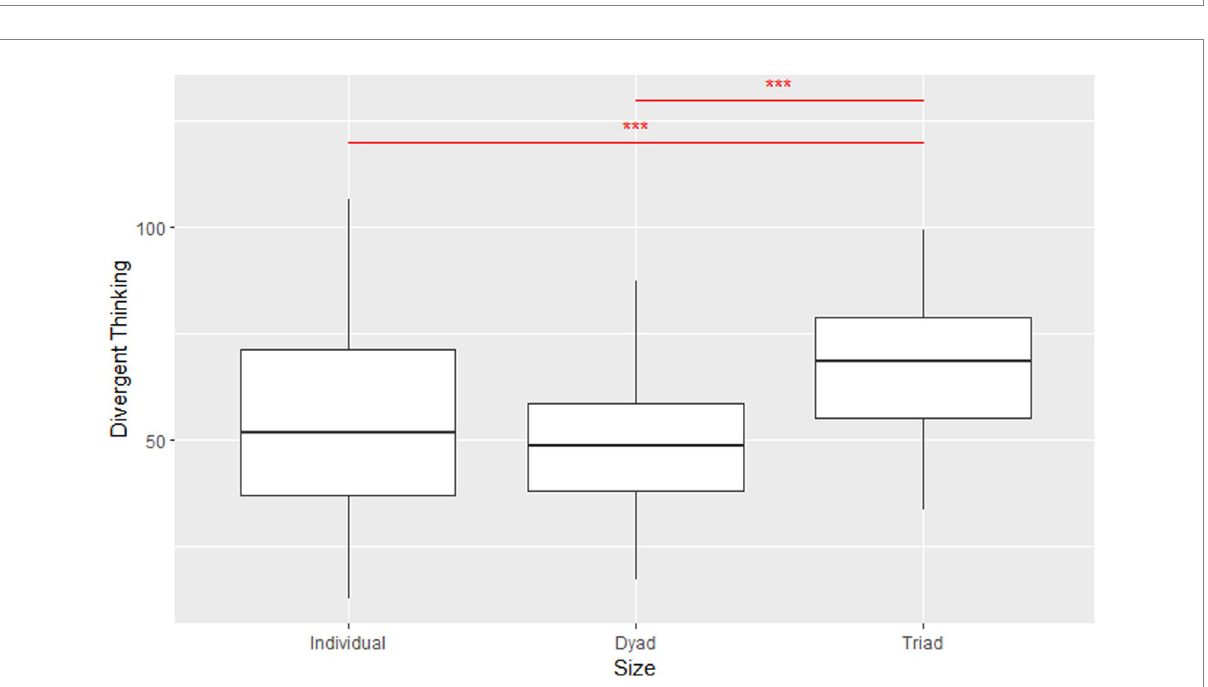
FIGURE 4 Comparison of AUT scores of individuals, dyads, and triads. Error bars represent standard errors of means. The Kruskal–Wallis test was applied. *** p <